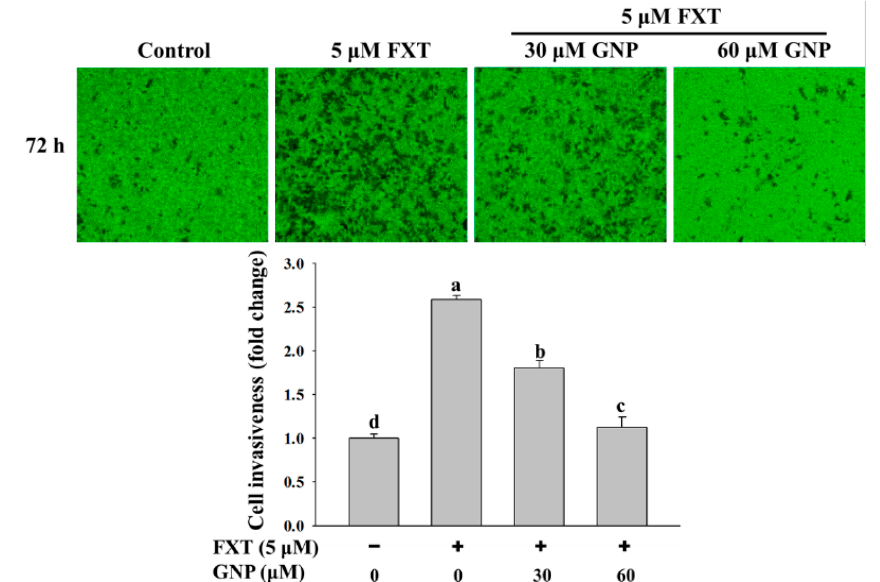
Figure 3. Matrigel invasion assay of FXT on HepG2 cells and the inhibitory effect of GNP. HepG2 cells were seeded onto a 24-transwell with serum-free medium at 5 × 10 4 cells/mL and incubated overnight, then treated with FXT-GNP at dose as indicated and further incubated for 72 h. DMSO (0.1%) was used as the vehicle control. Values are expressed as mean ± SD ( n = 3). Different letters indicate statistical significance ( p < 0.05).